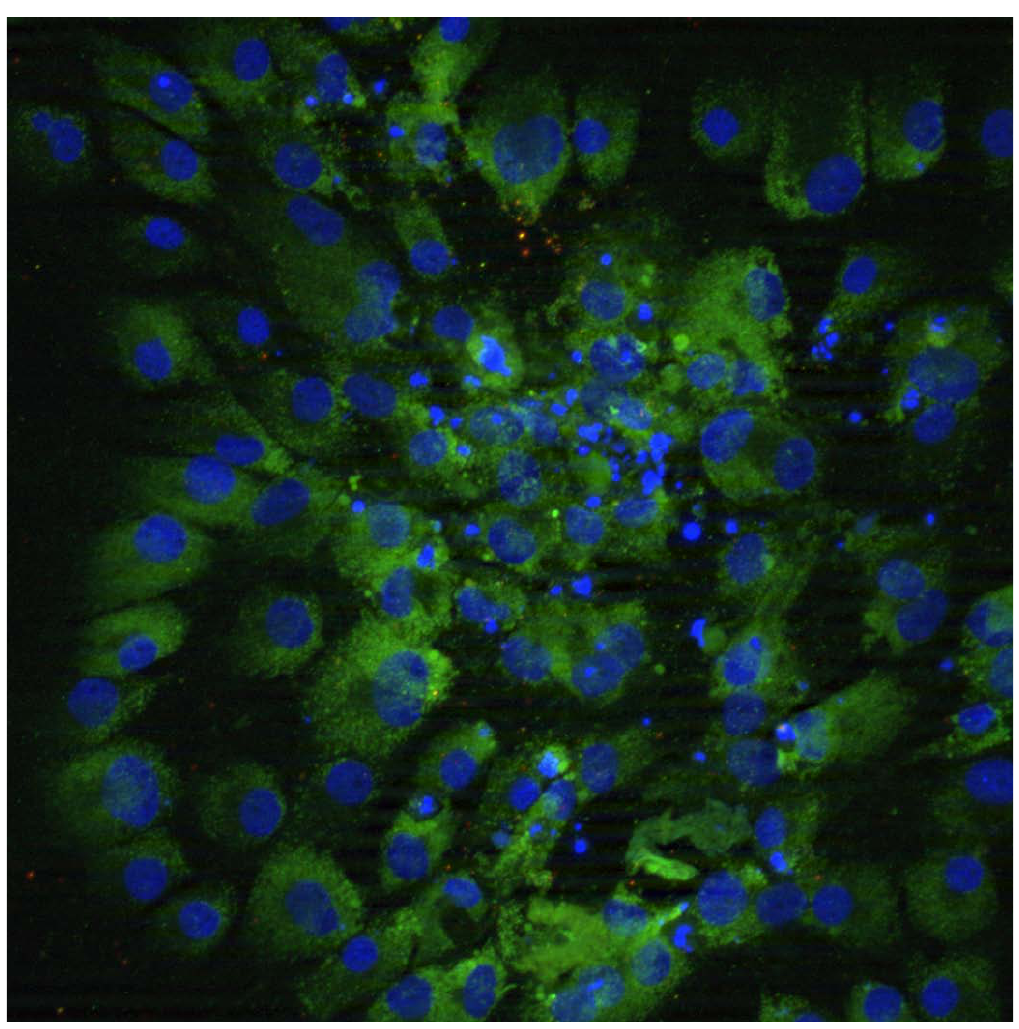
Figure 3. Immunocytochemical analysis of iPSCs in vitro. Immunocytochemistry revealed adenovirus-generated iPSCs (blue) can be differentiated into neural rosettes in vitro , expressing NCAM